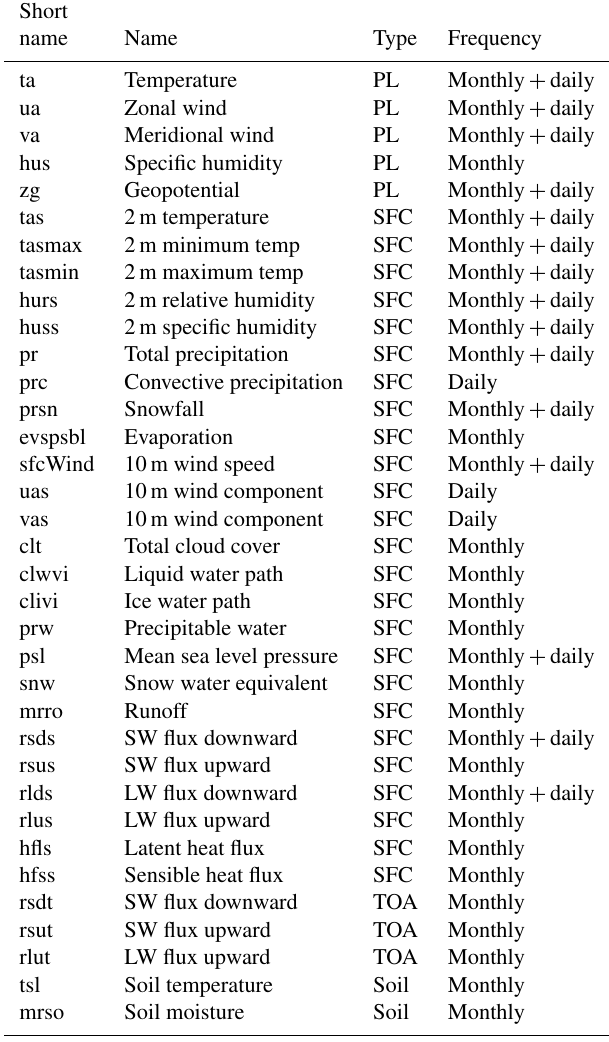
Table 2. Saved atmosphere variables. The column labeled “Type” indicates whether a variable is saved at the surface (SFC), at top of the atmosphere (TOA), in the soil, or on pressure levels (PLs). Monthly means are saved on 19 pressure levels (plev19 in the CMIP6 tables) and daily means and maxima on three pressure levels (plev3).